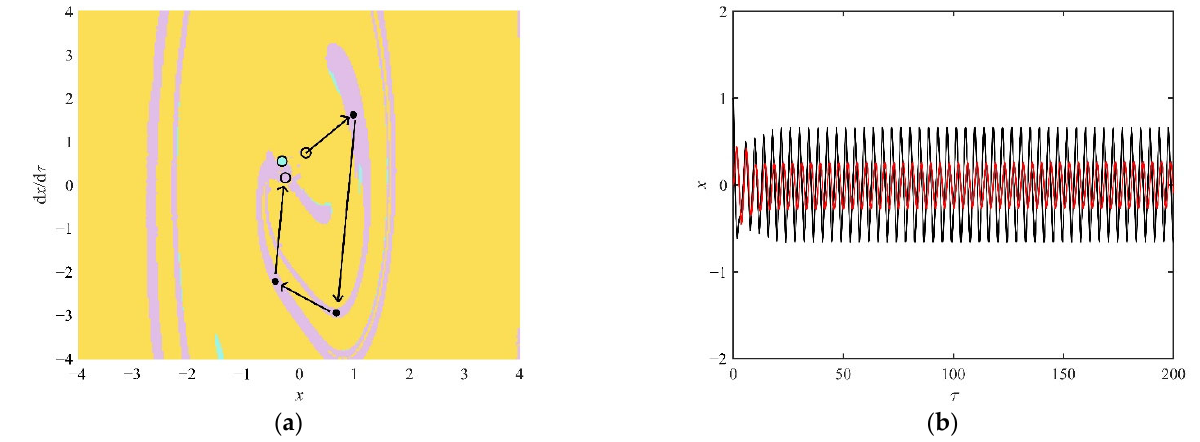
Figure 7. ( a ) The distribution of attractors in the frequency island; ( b ) the time history of vibration, the initial conditions of black line are selected as ( 0.5,0 ) , the initial conditions of red line are selected as ( − 0.5,0.5 ) .